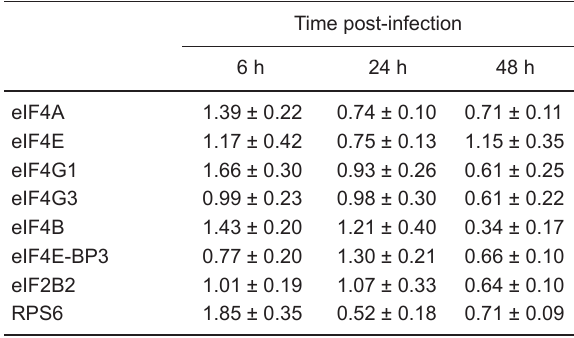
Table 1. 4E-BP1 phosphorylation is modified by dengue virus